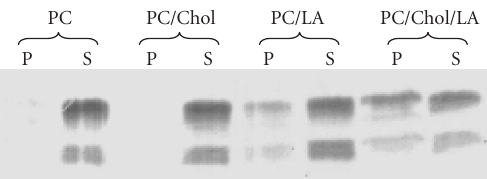
Figure 3: Cosedimentation analysis of the interaction between the C1q globular domain and artificial lipid vesicles. Vesicles